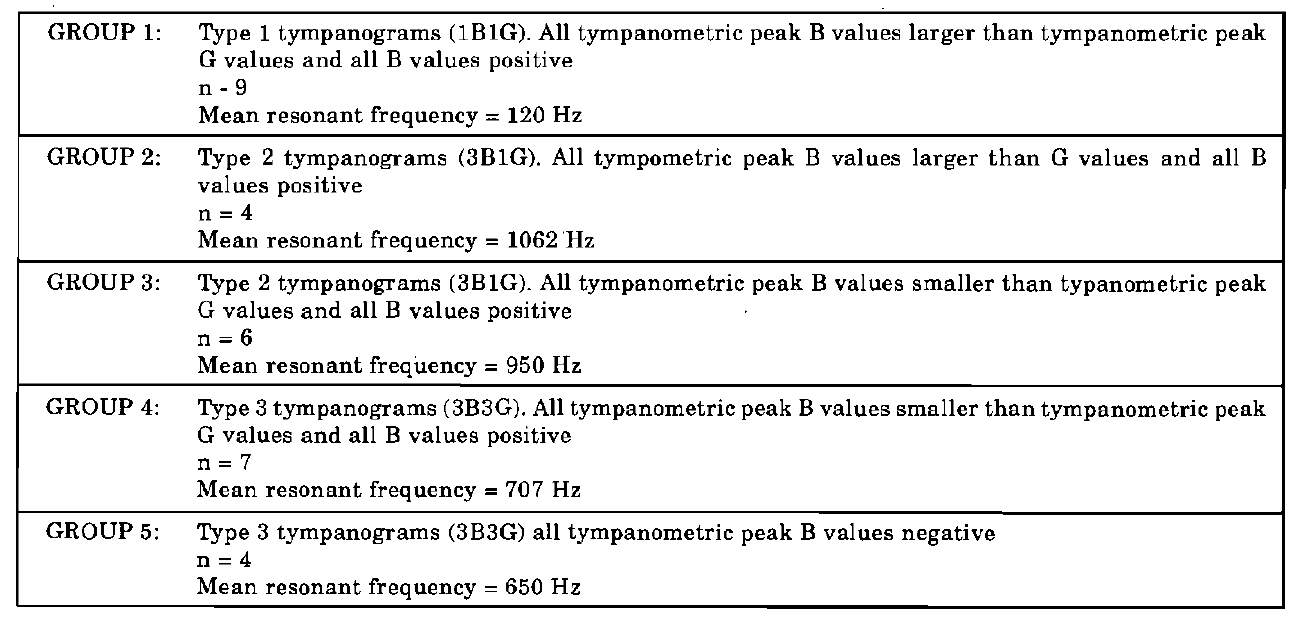
Table 2. Susceptance and conductance reflex patterns at threshold and suprathreshold levels for each group, recorded for the three stimuli at the 1000 Hz probe frequency.